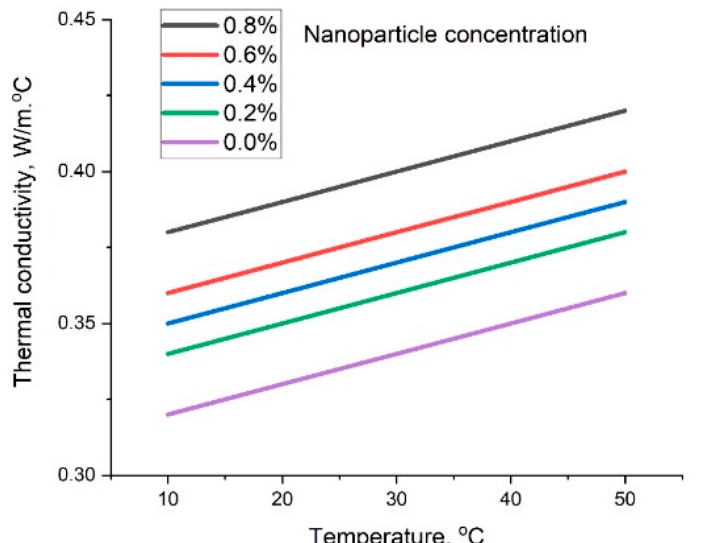
Figure 5. Comparison of thermal conductivity vs. temperature with nanoparticle concentration.